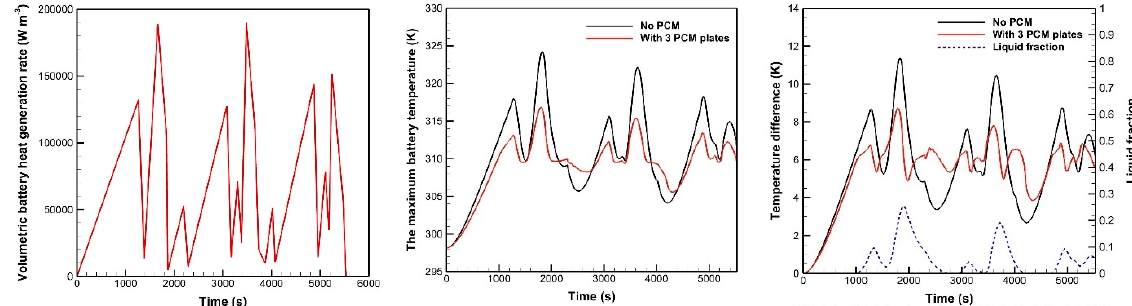
Figure 27. ( Left ): The volumetric battery heat generation rate (WLTP class 3 at T = 298.15 K); ( Middle ): Maximum battery temperature; ( Right ): Temperature difference and PCM LF for the hybrid BTMS with three PCM plates and active BTMS in a driving cycle. Reproduced from [102] with permission from Elsevier.